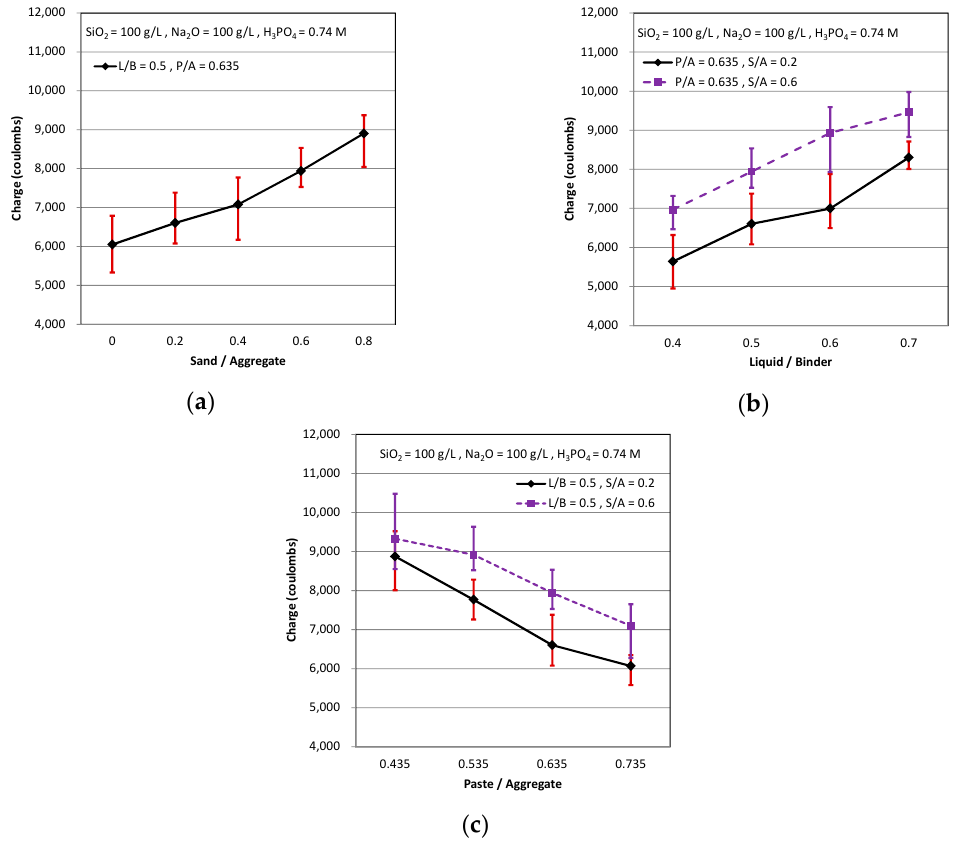
Figure 6. RCPT: ( a ) P/A = 0.635, L/B = 0.5; ( b ) P/A = 0.635, S/A = 0.2 & 0.6; and ( c ) L/B = 0.5, S/A = 0.2 & 0.6.